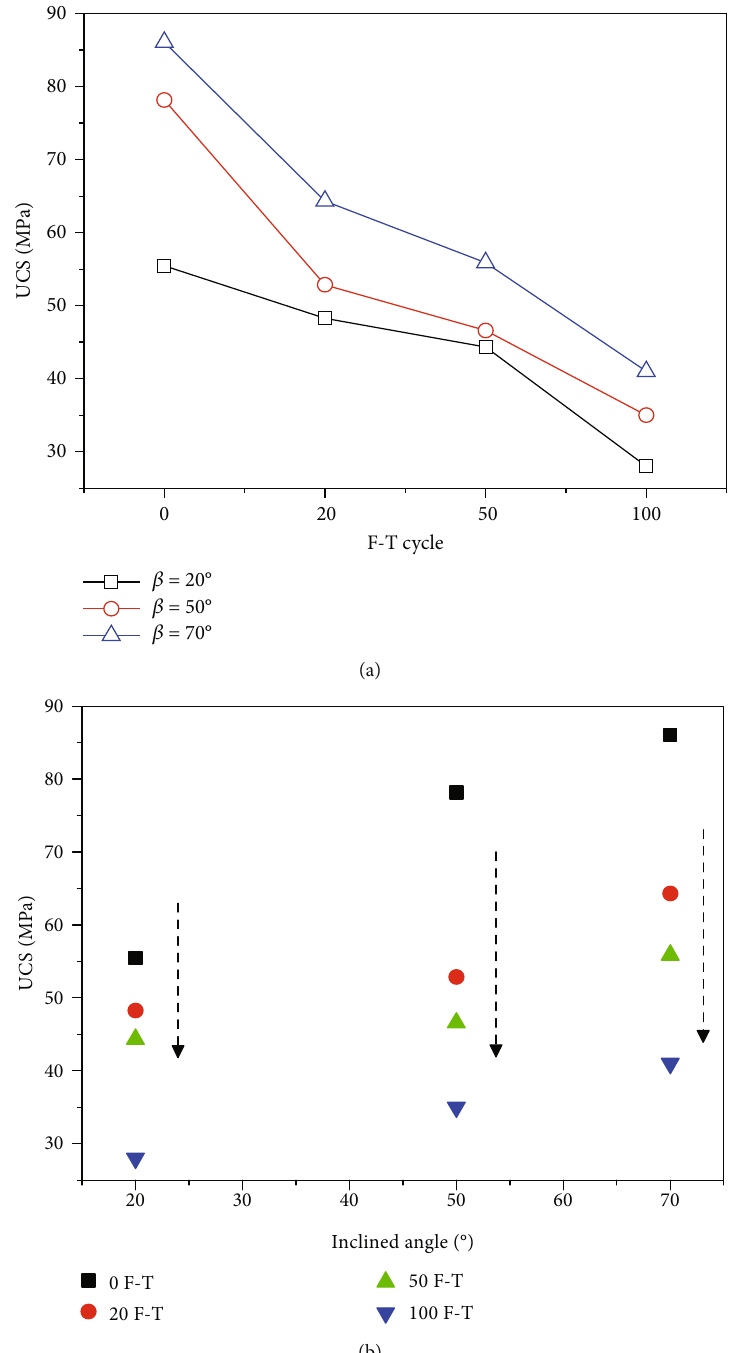
Figure 9: Uniaxial compressive strength (UCS) of the tested granite samples. (a) Changes of UCS with freeze-thaw cycles. (b) Changes of UCS with the approach angle de fi ned in Figure